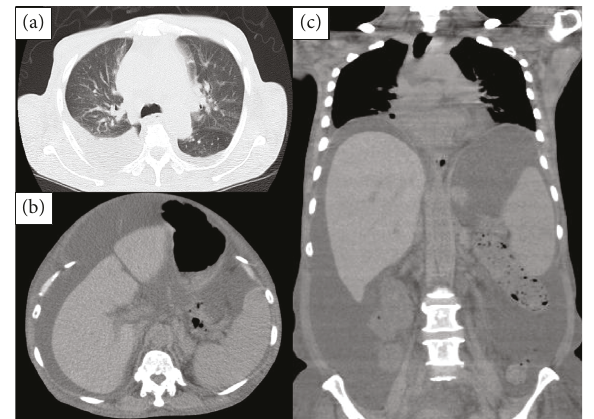
Figure 1: Computed tomography images, (a) lung image in transverse plane, (b) abdominal image in the transverse plane, and (c) thoracoabdominal image in the coronal